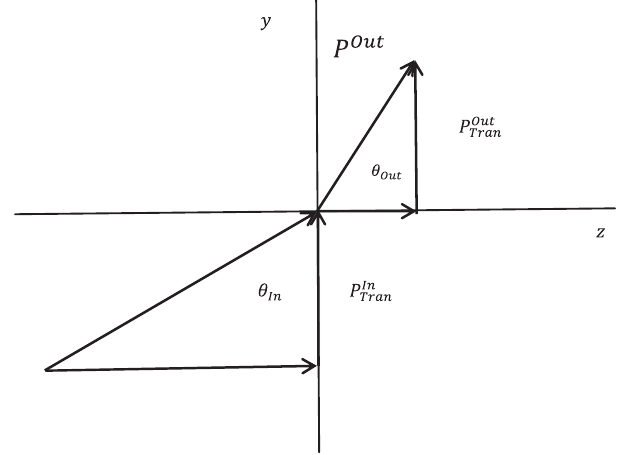
FIG. 9. The transverse momentum conservation diagram; the y axis is the cathode surface-vacuum interface, and the z axis is the direction of electron emission. There is a maximum value for θ for the electrons to be emitted